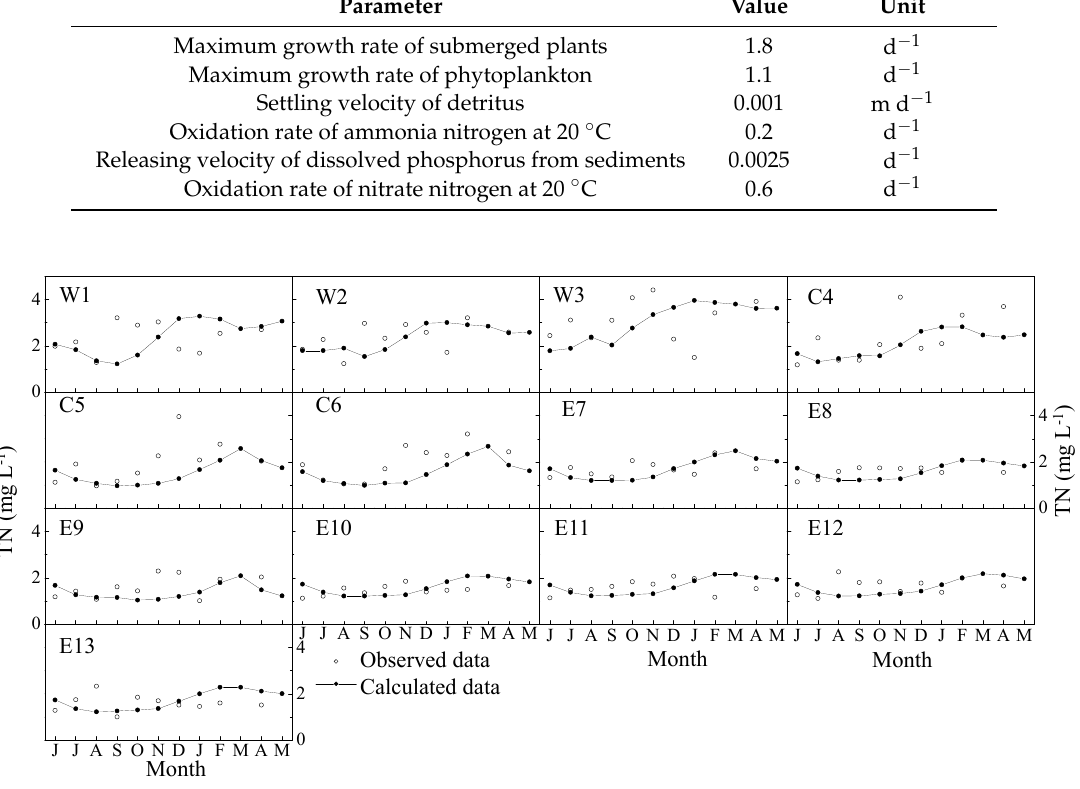
Figure 3. TN (mg L − 1 ) model (line + dots) and observed data (open dots) at 13 sites for June 2015 to May 2016.